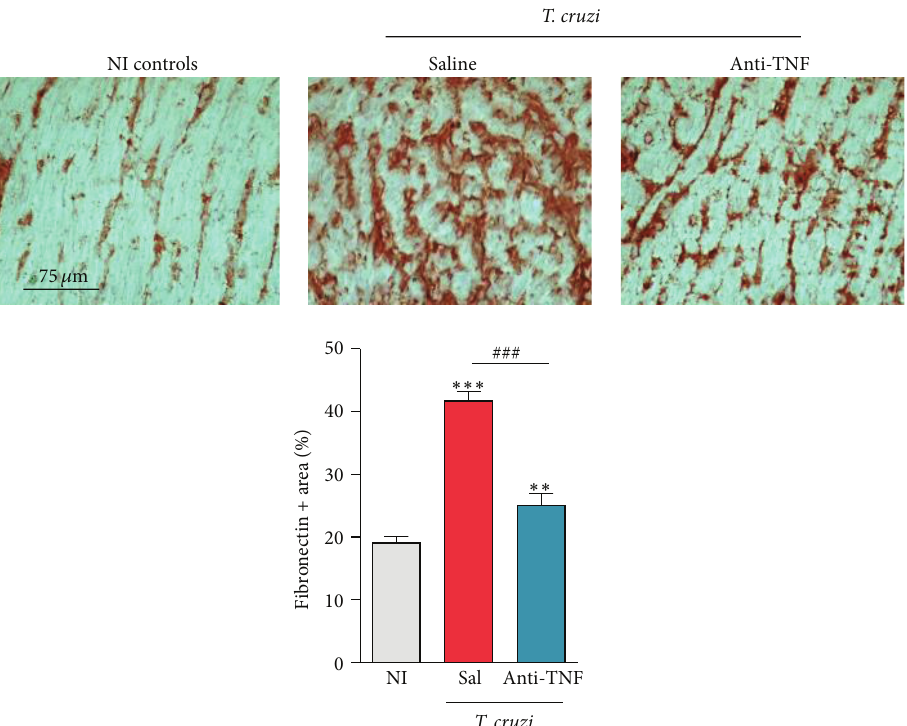
Figure 8: Anti-TNF therapy decreases fibronectin expression in the cardiac tissue of chronically Trypanosoma cruzi -infected mice. C57BL/6 mice infected with 100bt of the Colombian T. cruzi strain were treated from 120 to 150dpi and analyzed at 150 dpi. Representative heart sections from each experimental group analyzed by immunohistochemical staining to detect FN are shown. Data are expressed as percentage of FN-stained area (%). ∗∗ 𝑃 < 0.01 and ∗∗∗ 𝑃 < 0.001 , T. cruzi -infected mice (saline injected or anti-TNF treated) compared to NI controls. ### 𝑃 < 0.001 , anti-TNF-treated compared to saline-injected T. cruzi -infected mice. Bar represents the mean ± SD of the studied group (3 to 5 mice). These data represent three independent